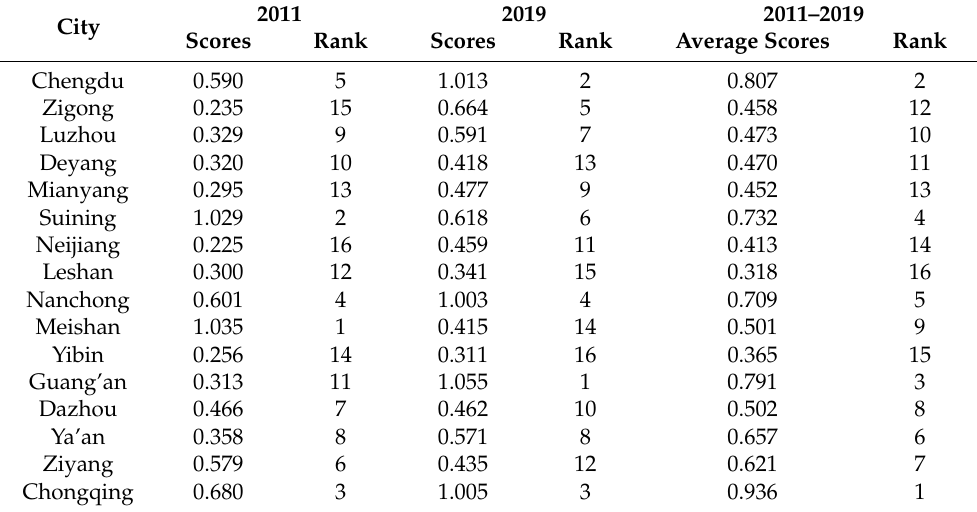
Table 4. Green technology innovation efficiency of 16 cities in the Chengdu–Chongqing urban